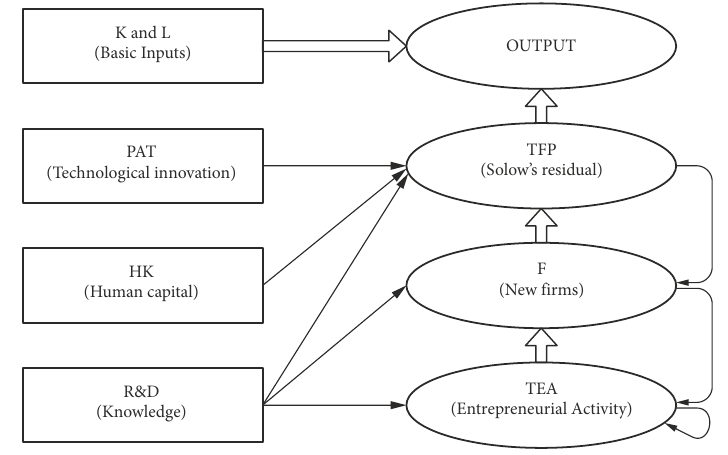
Figure 1. Scheme of the interrelationships of the proposed model (source: compiled by the authors from the system specification of the equations 8a, 8b and 8c)